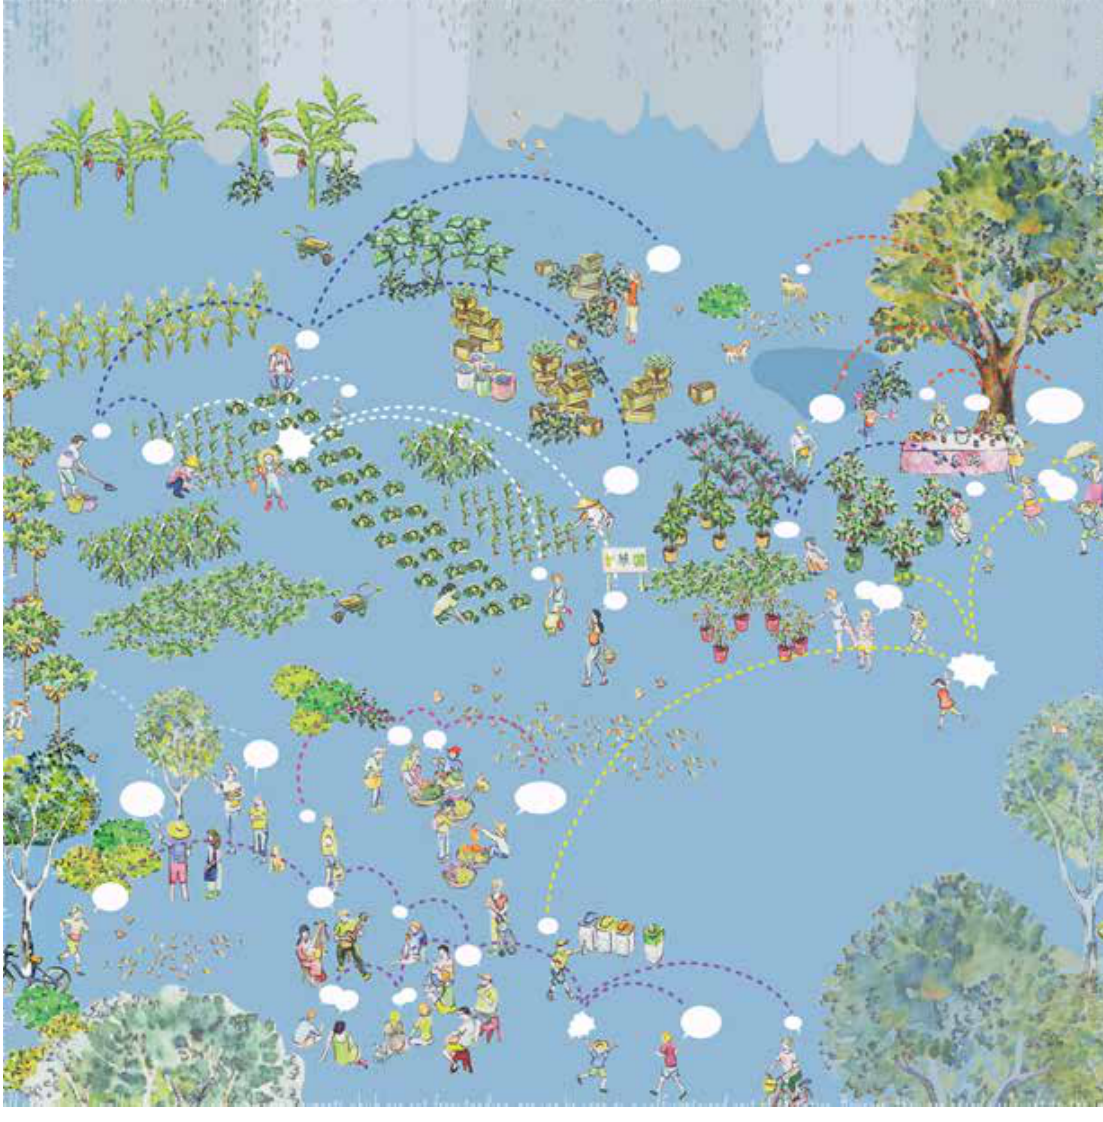
Figure 2 (previous page): Messages exchanged amongst local residents in an instant messaging app. Source: Jen Yoohyun Lee. Figure 3 (top): Conceptual visualisation of small stories dynamics occurring in a location-based community. Source: Jen Yoohyun